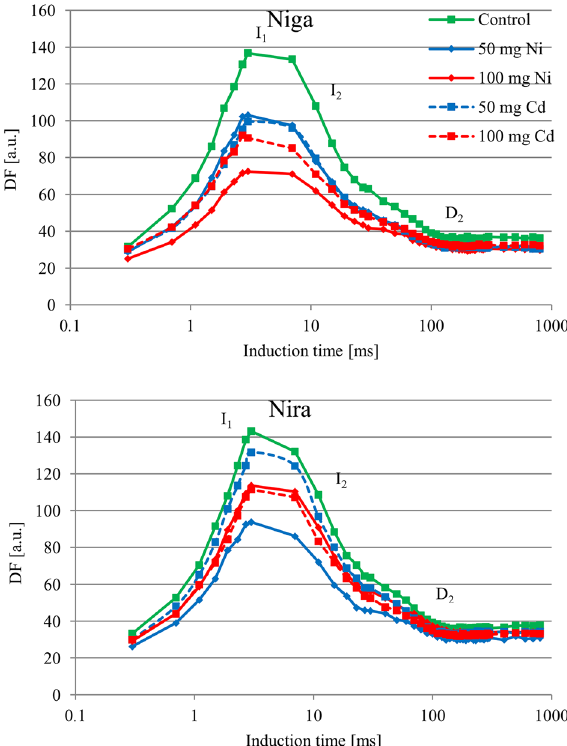
Figure 4. Delayed fluorescence induction curves [relative units] of two perennial ryegrass turf cultivars (‘Niga’ and ‘Nira’) under different Ni and Cd treatment (0; 50 and 100 mg × 100 g −1 of substrate) (n = 6).